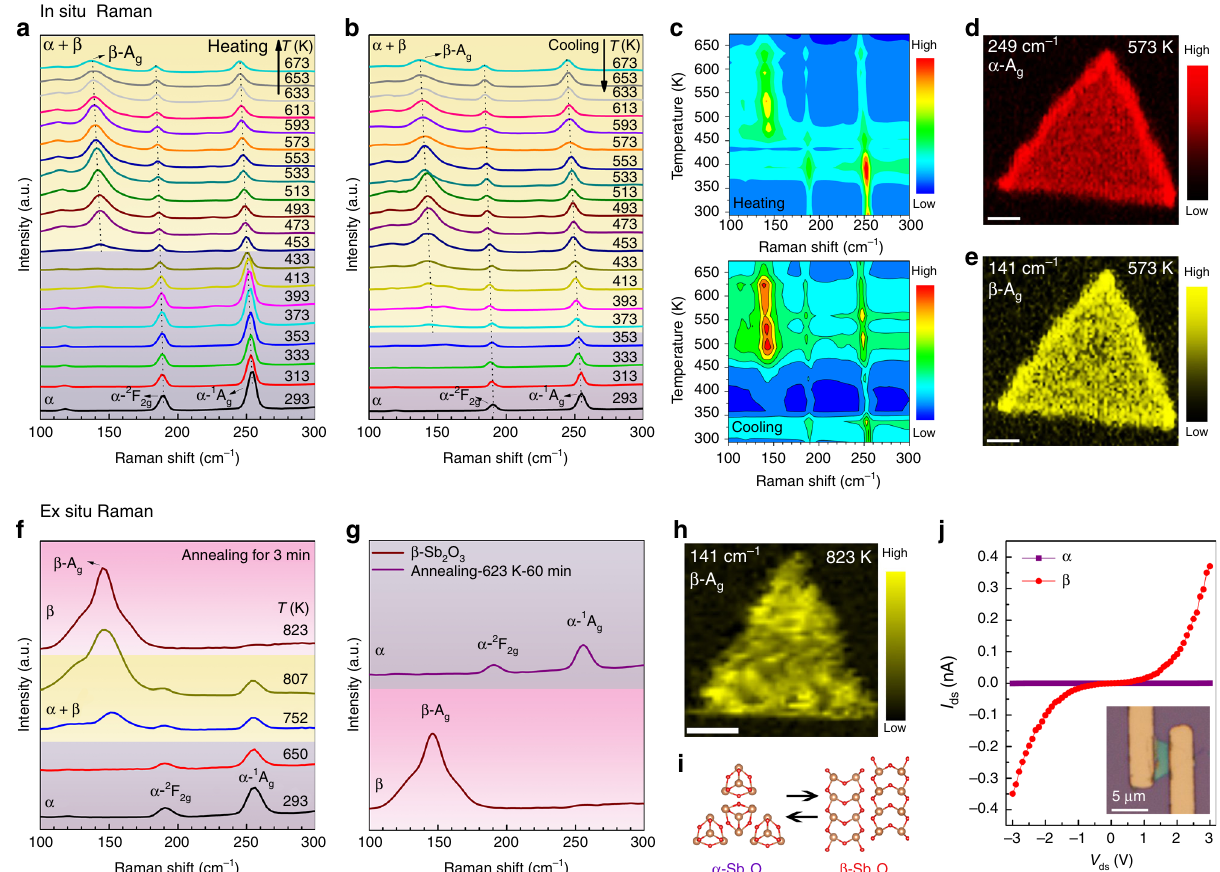
Fig. 5 Heat-induced phase transition in Sb 2 O 3 fl akes. a , b In situ temperature-dependent Raman spectra of a thin α -Sb 2 O 3 fl ake during heating and cooling processes with the temperature window of 293 − 673 K. c The corresponding 2D Raman intensity maps plot of temperature converted from ( a ) and ( b ). d , e Raman mapping images near 249 cm − 1 ( α -phase) and 141 cm − 1 ( β -phase) taken at 573 K. Scale bar, 2 μ m. f Ex situ Raman spectra of an Sb 2 O 3 fl ake acquired by annealing for 3 min at different temperatures. g Raman spectra of the β -Sb 2 O 3 fl ake before and after annealing for 60 min at 623 K. h Raman mapping image near 141 cm − 1 ( β -phase) taken after heat treatment at 823 K. Scale bar, 1 μ m. i Ball-and-stick structural models of α - and β -Sb 2 O 3 . Brown balls, Sb atoms; red balls, O atoms . j I – V curves of the Sb 2 O 3 device before ( α -phase) and after heat treatment ( β -phase). Inset is the optical image of